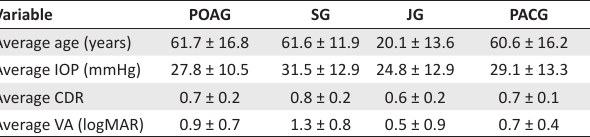
TABLE 3: Clinical characteristics of the types of glaucoma of the right eye of 311 patients. Variable